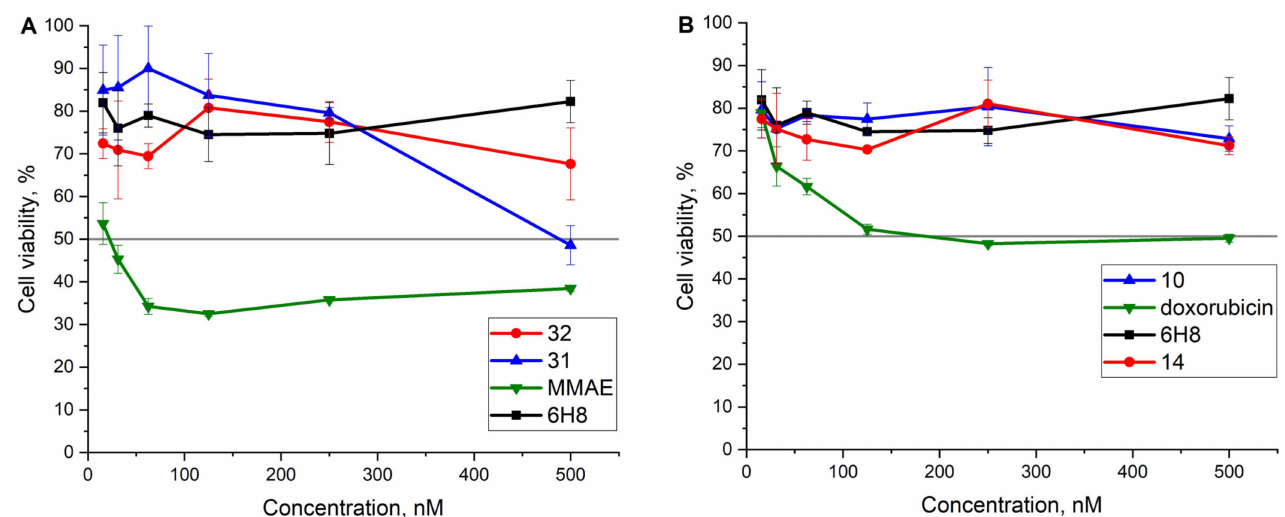
Figure 9. Viability of PRAME (-) murine colorectal carcinoma cell line CT26 analyzed by MTT